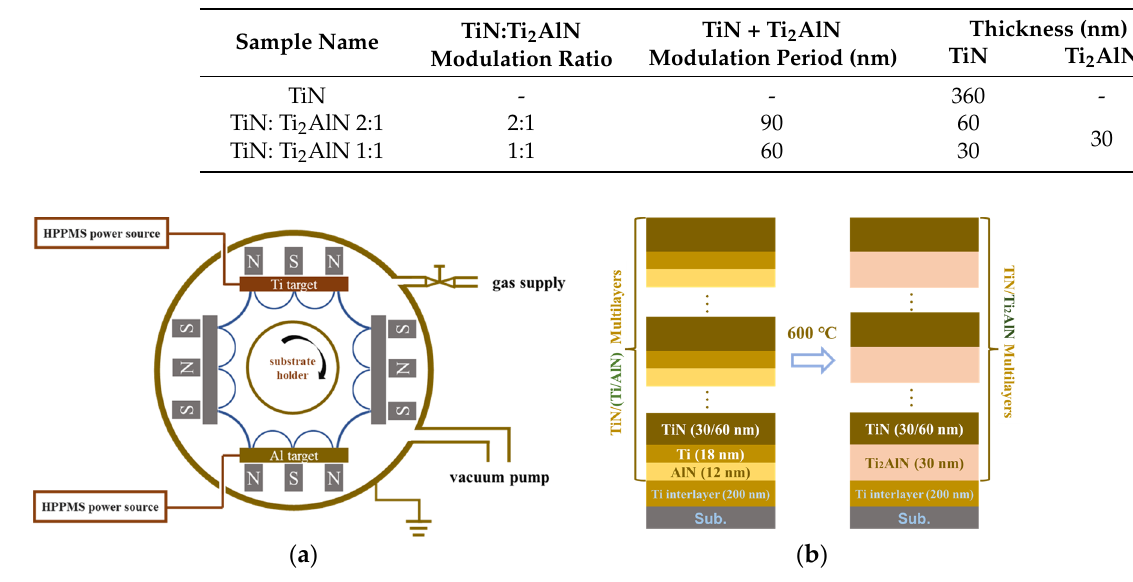
Figure 1. Schematic diagram of the high-power pulsed magnetron sputtering system ( a ) and the as-deposited TiN/(Ti/AlN) and TiN/Ti 2 AlN multilayers ( b ).